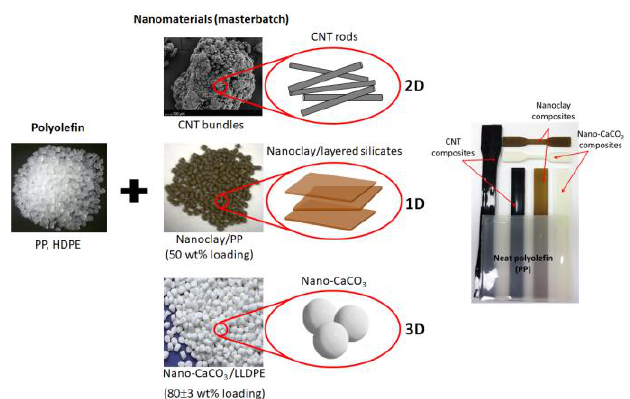
Fig. 2. Polyolefin based nanocomposites with three different types of nano-